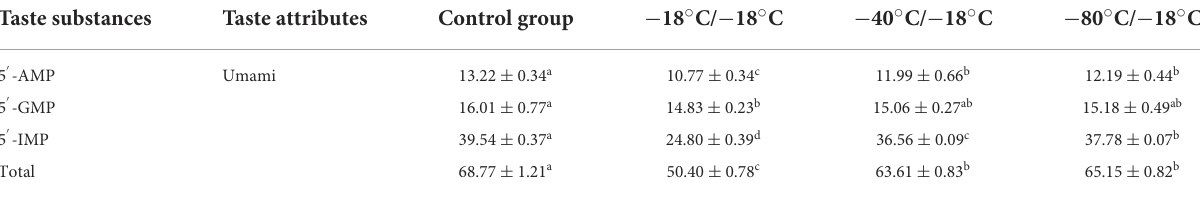
TABLE 5 Taste nucleotides of HGM with different freezing